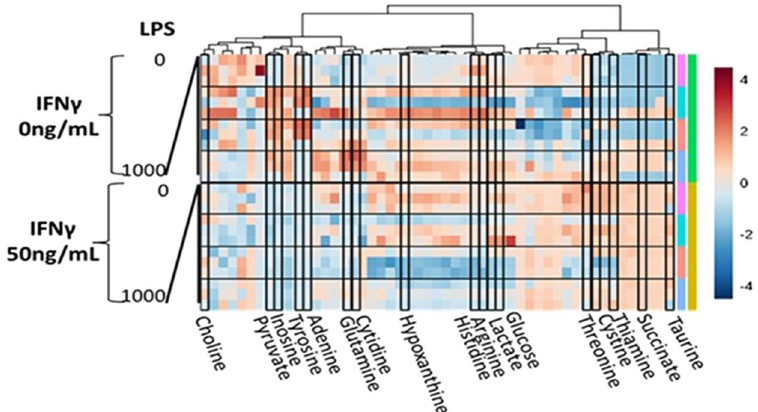
Figure 4. UPLC-MS analysis of extracellular concentration of 54 metabolites. Relative differences in media concentration of 54 metabolites after 24 hr LPS and IFN γ treatment of HUVECs, metabolites forming model bounds